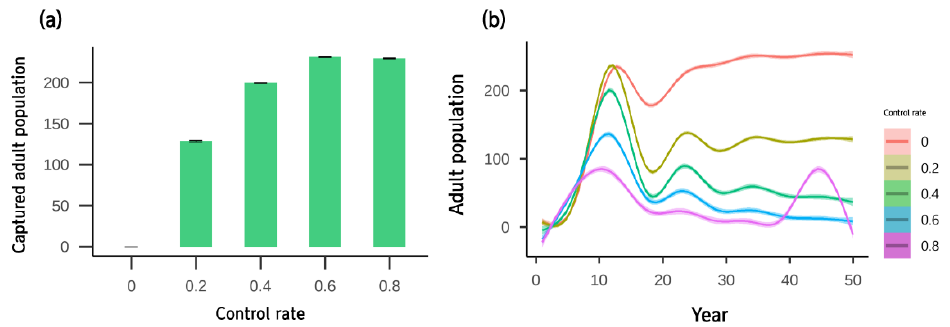
Figure 6. ( a ) The effects of the control rate on captured adults during the simulation period and ( b ) the adult population of each control rate over time. Results show the mean and SE with 30 replicates.